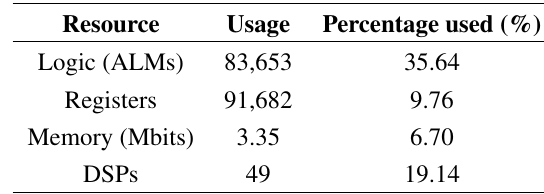
Table 1. FPGA resource